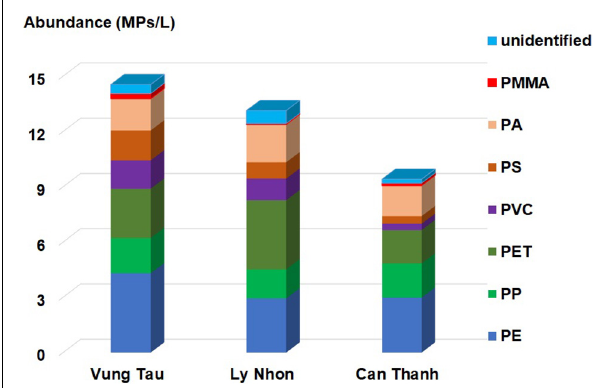
FIGURE 2 | Compositions of microplastics filtered from the seawater